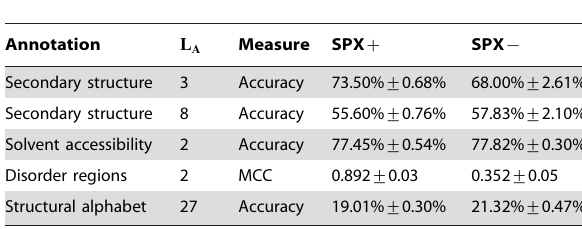
Table 2. Cross-validated accuracies of